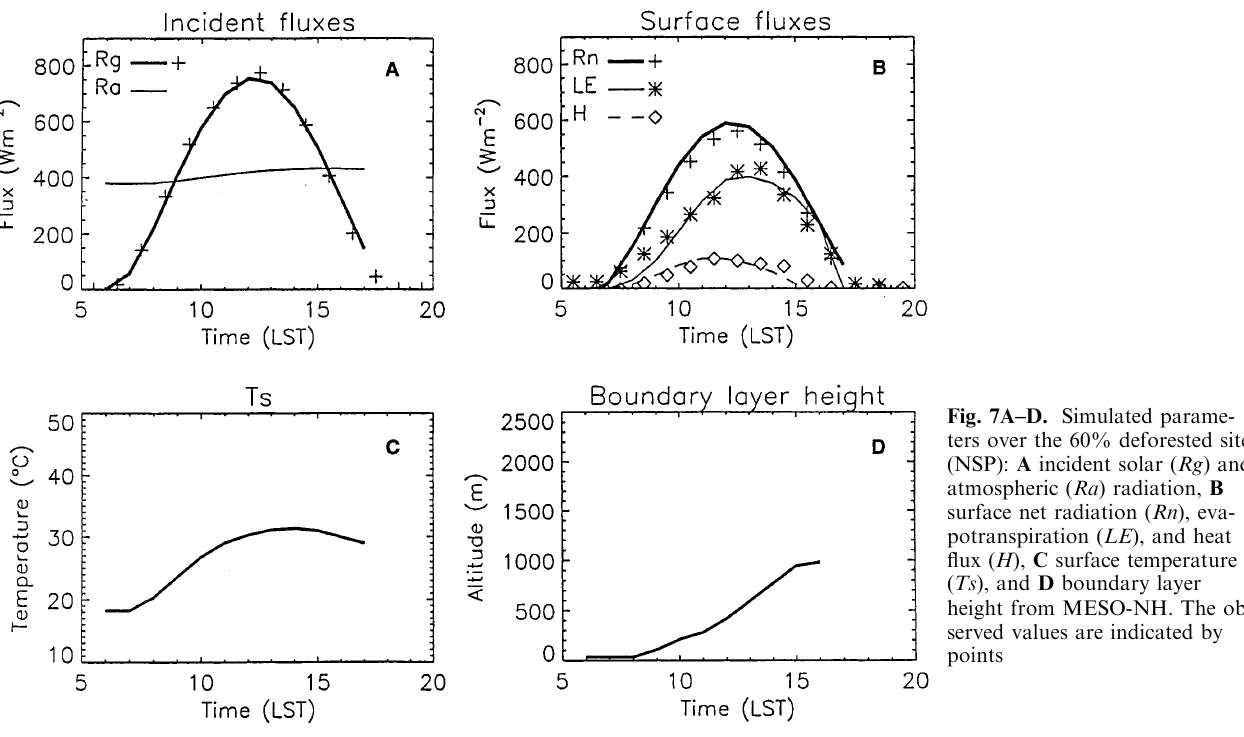
Fig. 7A–D. Simulated parame- ters over the 60% deforested site (NSP): A incident solar ( Rg ) and atmospheric ( Ra ) radiation, B surface net radiation ( Rn ), eva- potranspiration ( LE ), and heat flux ( H ), C surface temperature ( Ts ), and D boundary layer height from MESO-NH. The ob- served values are indicated by